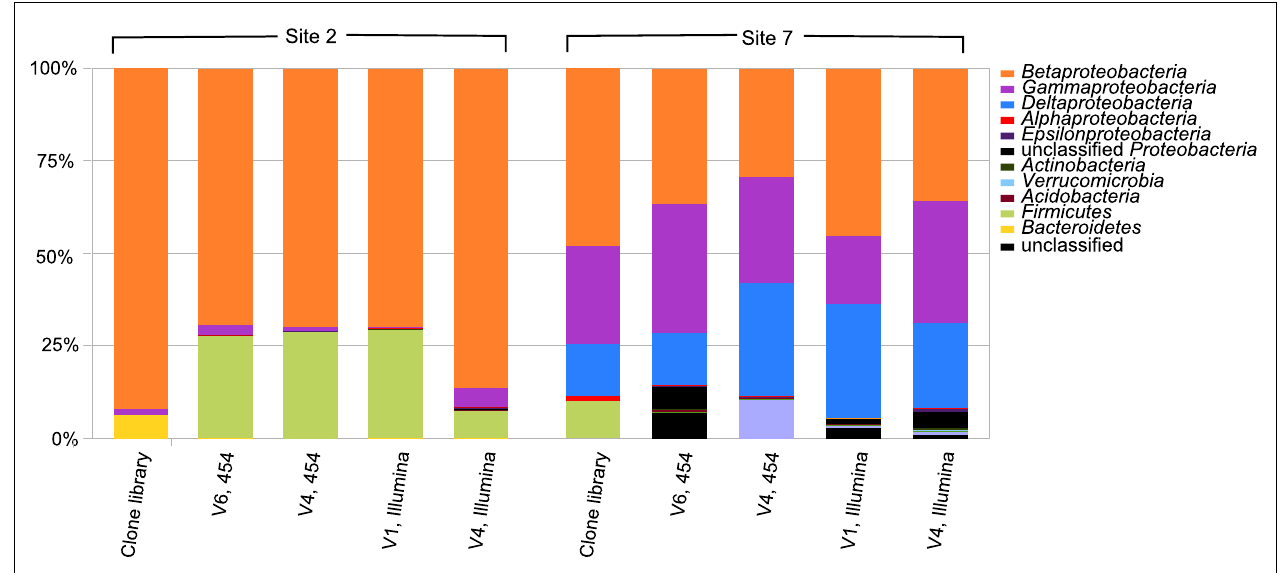
FIGURE 7 | Relative abundance of taxa at the phylum/class level in the 16S rRNA gene clone and barcode libraries from sites 2 (microbial mat) and 7 (puffball). V1,V4, andV6 refer to different variable regions of the 16S